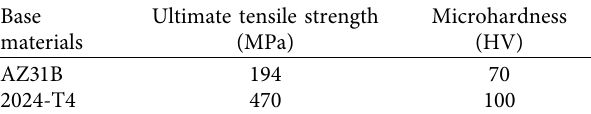
Table 3: Mechanical properties of base metal.